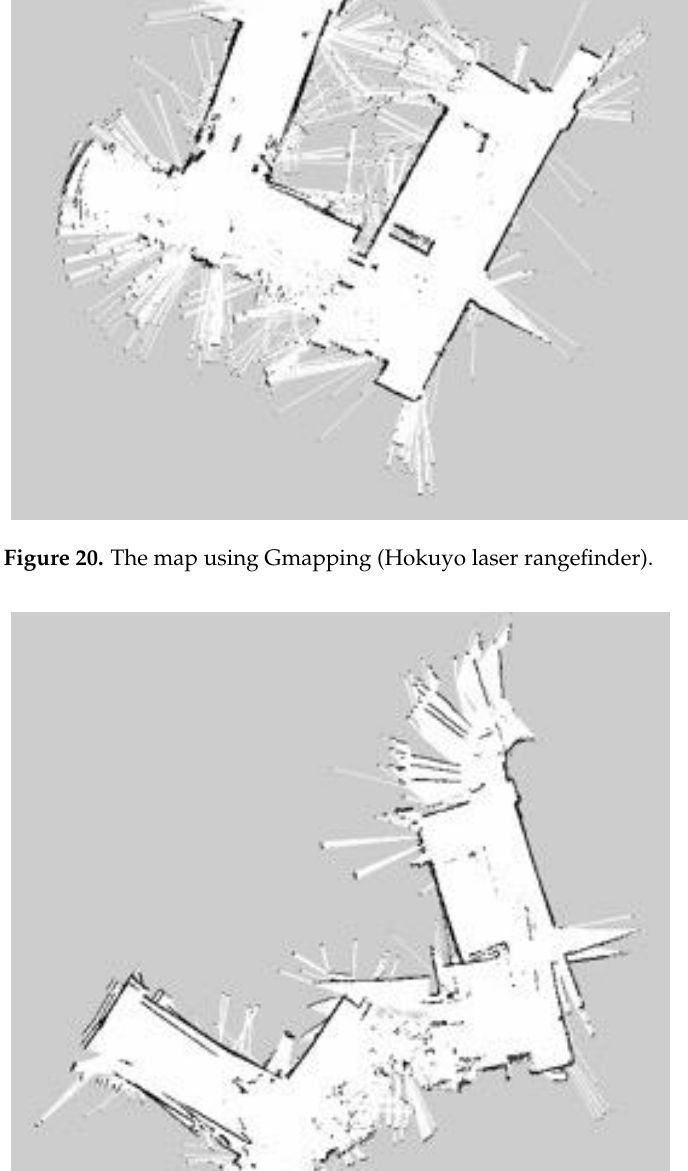
Figure 22. The map using Cartographer (Hokuyo laser rangefinder).